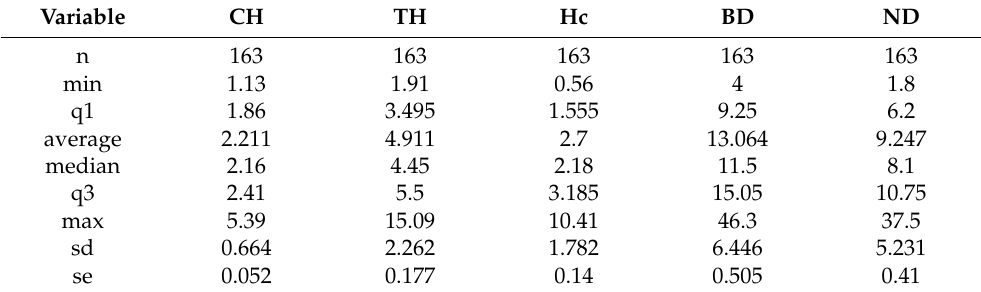
Table 1. Statistical description of the trees recorded in “El Cordoncito”.